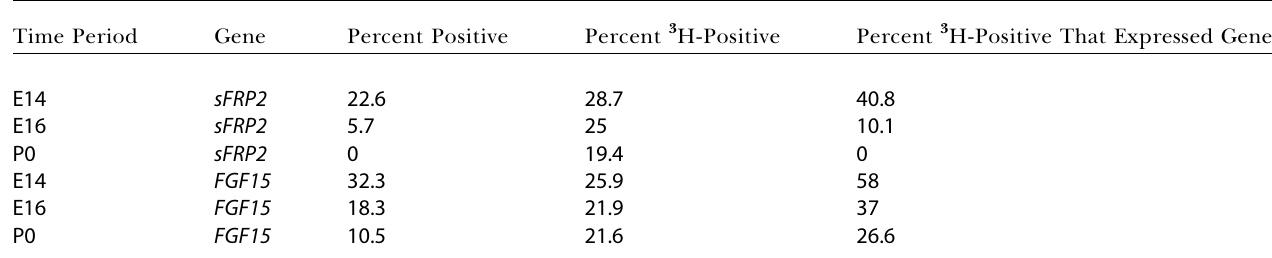
Table 2. Fraction of Progenitor Cells Expressing sFRP2 and FGF15 Decreased as Development Proceeded Time Period